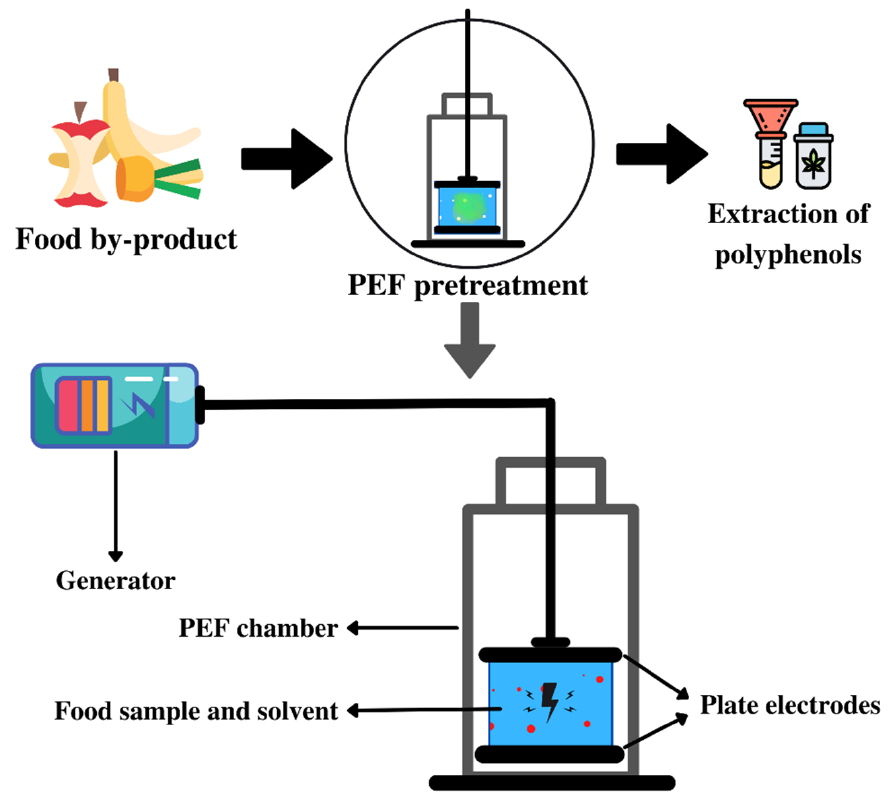
Figure 7. Simplified schematic of extraction of polyphenols using PEF pretreatment. Peir ó et al. (2019) evaluated the influence of PEF pretreatment in the recovery of polyphenols from lemon residues using pressing extraction technique, and they reported that the electric field intensity of 7 kV/cm and applying 30 pulses in the duration of 3 µ s increased the efficiency of polyphenol extraction by 300% compared to the untreated extracts [105]. Moreover, Rajha et al. (2019) used different nonthermal treatments, including PEF, in the extraction process from pomegranate peels, and they concluded that PEF with